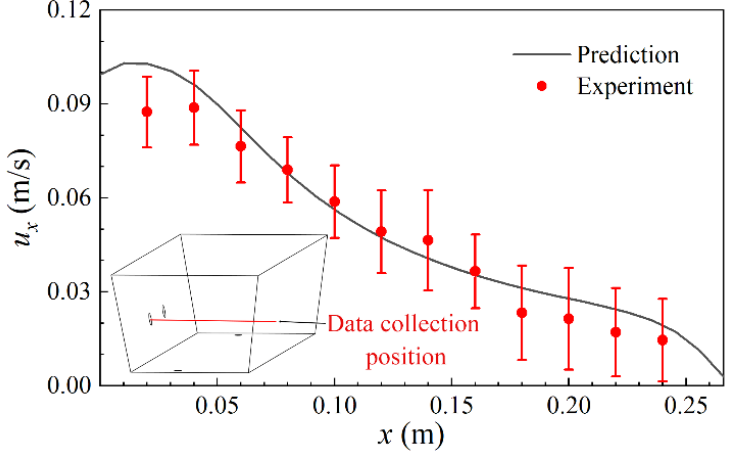
Figure 5. Comparison of calculated and measured x component of water velocity ( u x ) along extension line at the center of the channel outlet of the water model of tundish A.